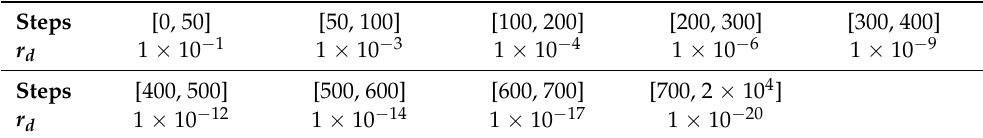
Table 1. Piecewise parameter of r d as iteration, from